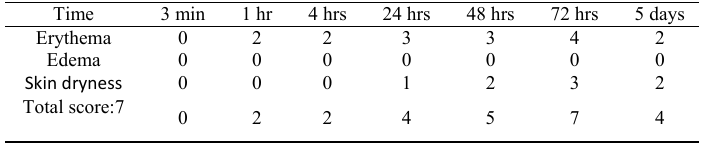
Table5: skin reactions of rabbit 2 after 3 min, 1 hr, 4 hrs, 24 hrs,48 hrs , 72 hrs and 5 days to proposed Blank